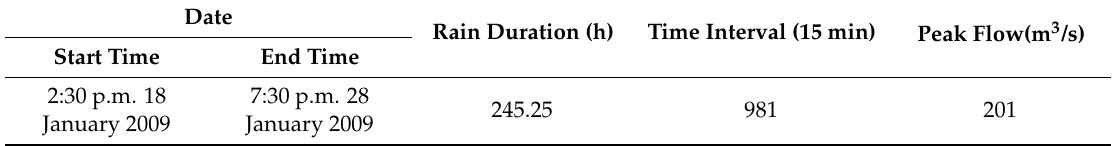
Table 2. Characteristics of the actual event investigated.